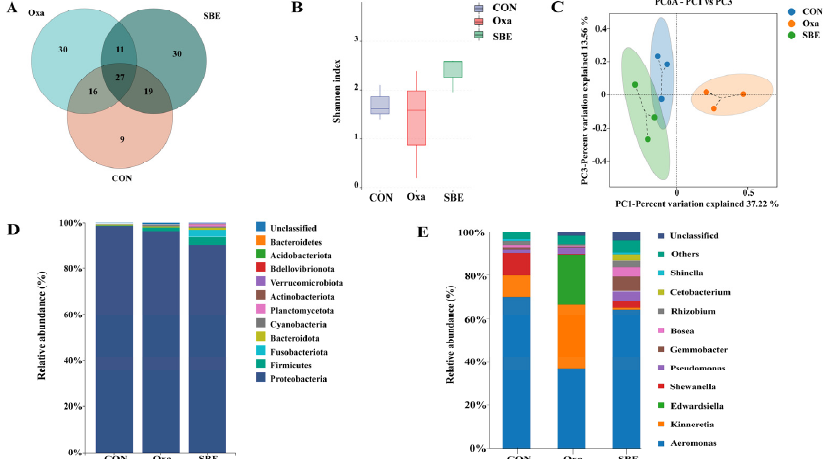
Figure 5. Effects of SBE on intestinal microbiota in zebrafish. A Venn diagram shows the overlap of the OTUs identified in the intestinal microbiota among CON, Oxa, and SBE groups ( A ). Analysis of alpha diversity (Shannon index) was used to detect differences between the groups ( B ). Plots of unweighted UniFrac-based PCoA ( C ). The top 15 bacteria, with a maximum abundance of gut bacteria at the phylum level ( D ). The top 15 bacteria, with a maximum abundance of gut bacteria at the genus level ( E ).